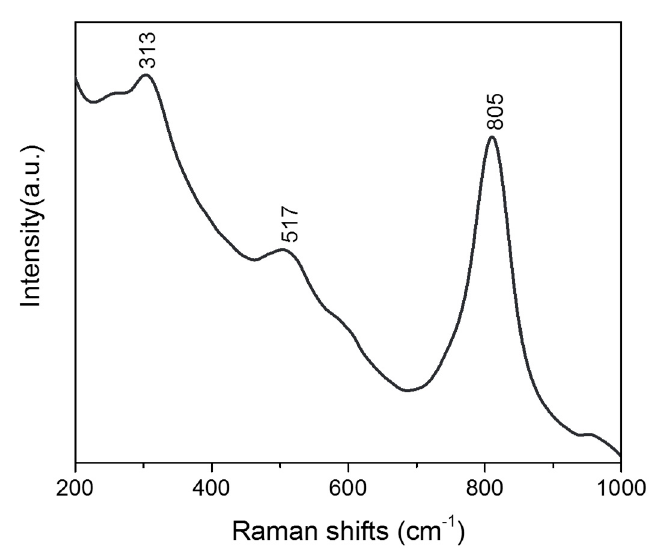
Figure 9. Raman analysis of BiVO 4 microspheres at 400 °C.